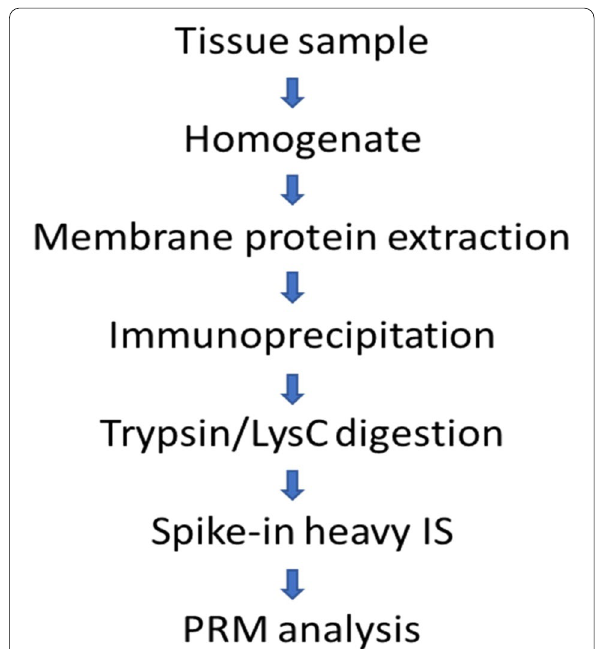
Fig. 1 Workflow of human CFTR protein quantitation in